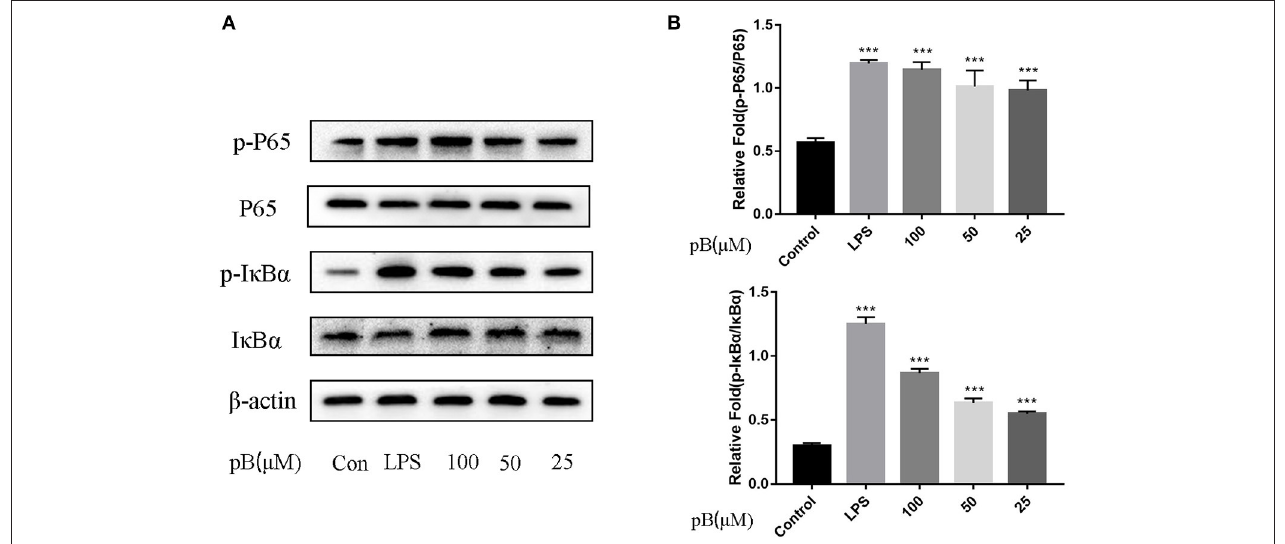
FIGURE 5 | Effects of pB on the nuclear factor-kappaB (NF-kB) pathway with Western blotting. (A) The expression of p-P65, P65, p-I κ B α and I κ B α were detected using Western blotting. (B) The ratio of the content of p-P65/P65 and p-I κ B α /I κ B α . Data presented are the mean ± SD, n = 3. Compared with the control, *** p < 0.001.